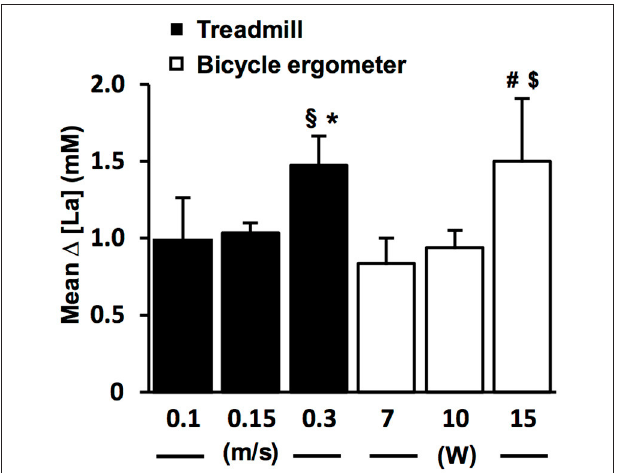
FIGURE 3 | The lactate increase is augmented with higher increments at the individual lactate threshold. Relationship between workload (WL) increment ( 1 V, 1 P) and arterial lactate increase ( 1 [La]) at the lactate threshold (LT) detected with threshold criterion 1 (TC1) on the treadmill ( n = 169, black bars) and bicycle ergometer ( n = 69, white bars). The [LA] increase starts to appear after a slight workload increment of 0.1–0.15 m/s in running and 7–10W in cycling, and gets more pronounced with higher workload increments. § P = 0.02 vs. 0.15 m/s (two-tailed unpaired t -test); * P < 0.001 vs. 0.15 m/s (Mann-Whitney-U-Test); # P = 0.002 vs. 7W (Mann-Whitney-U-Test); $ P < 0.001 vs. 10W (two-tailed unpaired t -test). Data are expressed as means ±